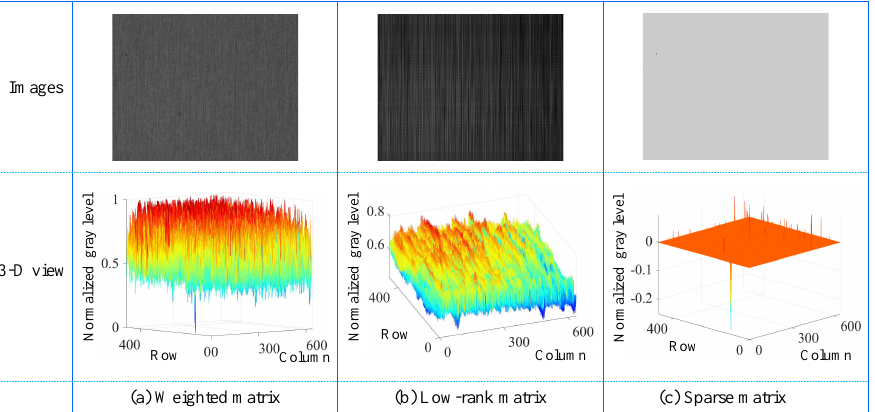
Figure 4. Matrix decomposition in single-defect images. The first column is a weighted matrix, which is decomposed into low-rank (in second column) and sparse matrices (in third column), respectively.